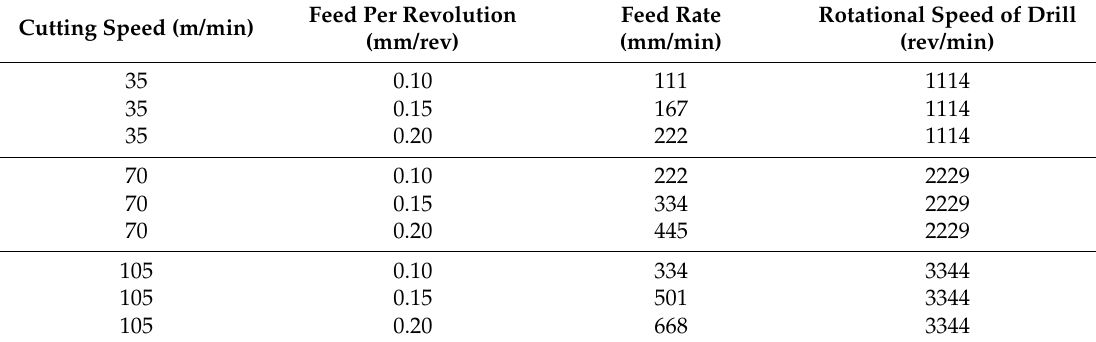
Table 3. Machining